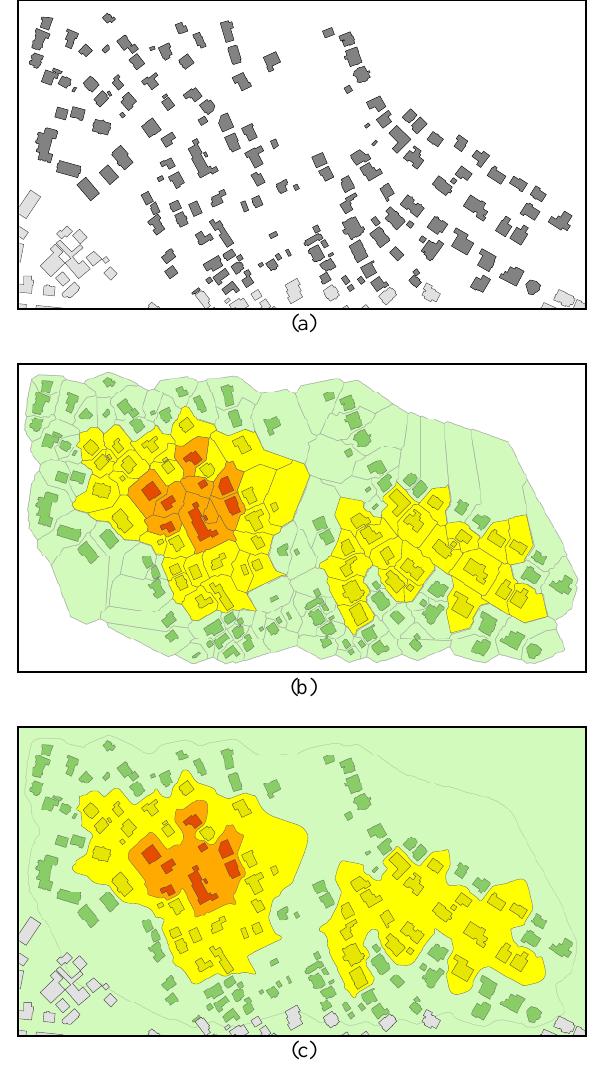
Figure 4. The initial test area (dark gray foot prints) (a), regions with three different anonymity levels (green, yellow and orange) with the indicated privacy cells (b), final privacy map